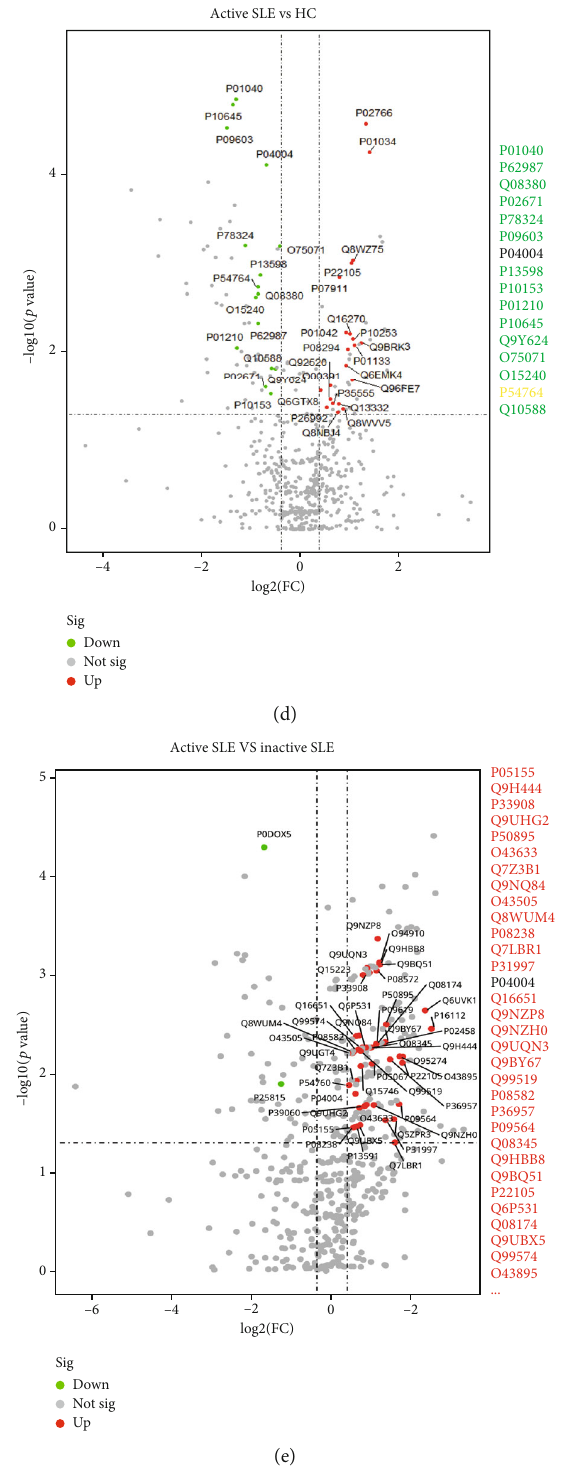
Figure 1: Pro fi le of urinary proteins. (a) Heatmap shows the di ff erentially expressed genes (DEGs) re fl ected by di ff erentially expressed matching proteins in the indicated groups (group 1/G1: healthy controls, group 2/G2: inactive JSLE patients, and group 3/G3: active JSLE patients). Red and green colors indicate higher and lower expression, respectively. (b – e) Volcano dot plot presents the mass spectrometry data of proteome as -log10 ( p value) plotted against the log2 (fold change/FC). The -log10 ( p value) and log2 (FC) analysis thresholds are indicated by dotted lines ( ≥ 1.3-fold upregulation or ≤ 0.77-fold downregulation, p < 0 : 05 ). Green dots represent the downregulated proteins, while red dots represent the upregulated proteins and gray dots represent no signi fi cant di ff erence in proteins. The symbol of di ff erentially expressed proteins labeled with relevant color is listed beside each